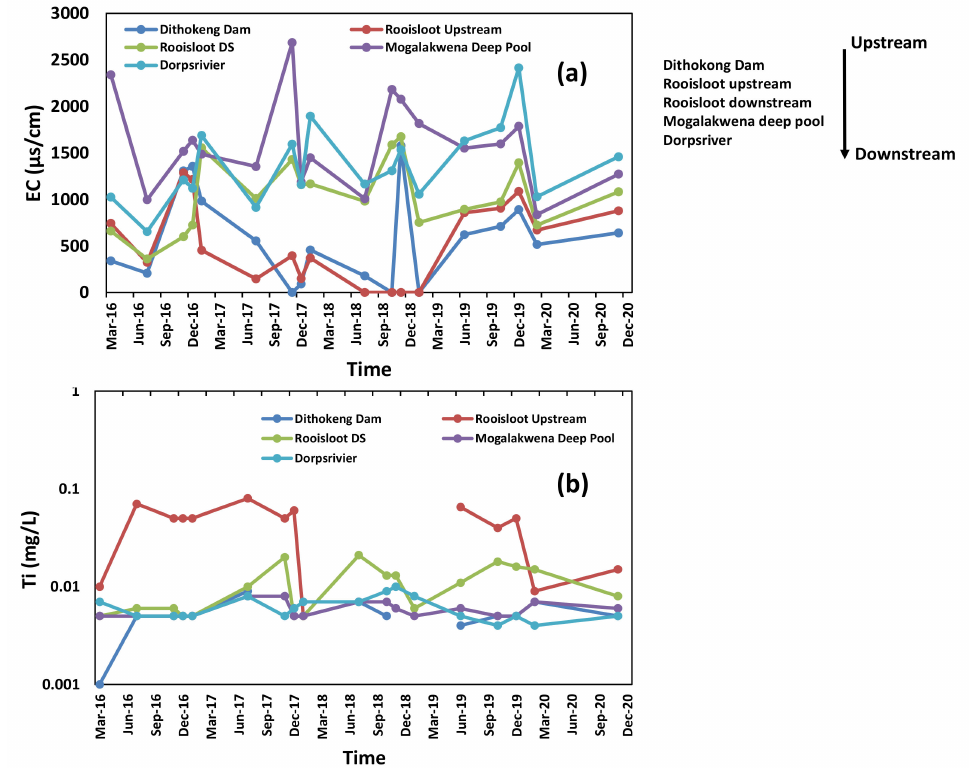
Figure 4. Time series concentration values for ( a ) EC and ( b ) Ti for water samples at five sampling locations.